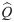
Robustness of the estimation procedure of C and Σ on artificial networks.A Left: Comparison of the C error (red curves) and Σ error (purple curve) for optimization based on several τest. For the C error, the cluster-hub topology in Fig 1A corresponds to lighter red and the random connectivity to darker red. The plot is similar to Fig 3C; the error bars correspond to the standard deviation over 40 network configurations. Right: Similar plot for the error of asymC for the two network topologies. B Pearson correlation coefficient between the matrix elements of the whole recovered and original C matrices in red; idem but limited to non-zero elements of the original C in yellow; and between the recovered C and the symmetric part of the original C in green. The plot concerns 50 networks of either topology for which the asymmetry of original C is larger than 0.5; LO is performed using τest = 1 s. C
C and Q errors (in red and blue, respectively) plotted against several parameters for the network and LO: the number of simulations used to calculate the empirical Q^, the network size N and the asymmetry of the original C. Each cross/dot corresponds to one of the 80 simulations of either topology in A for τest = 1 s. D Comparison of the estimation performance of LO wit the direct and heuristic methods for the C error (left), the Σ error (middle) and asymmetry error (right). For each case, the left boxplot correspond to 40 cluster-hub networks and the right one to 40 randomly connected networks; the optimizations are performed with τest = 1 s. Contrary to others, the asymmetry error is not normalized.